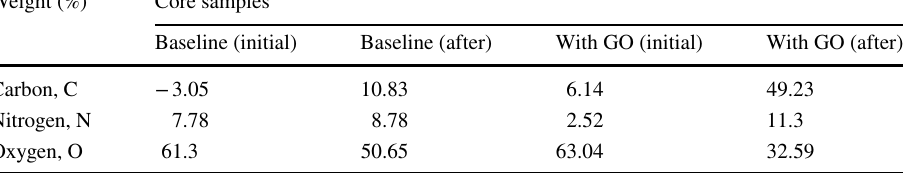
analysis of core